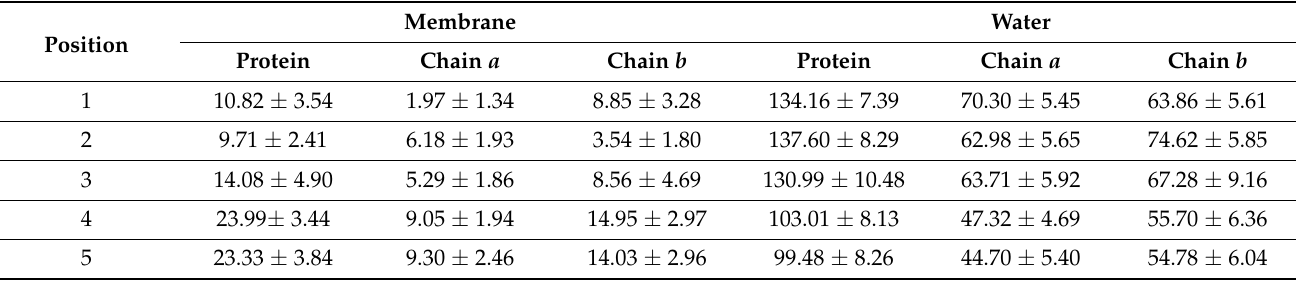
Table 1. Average number of hydrogen bonds formed by HD5 protein with membrane and water molecules. Hydrogen bonds of each chain are also shown. Membrane Position